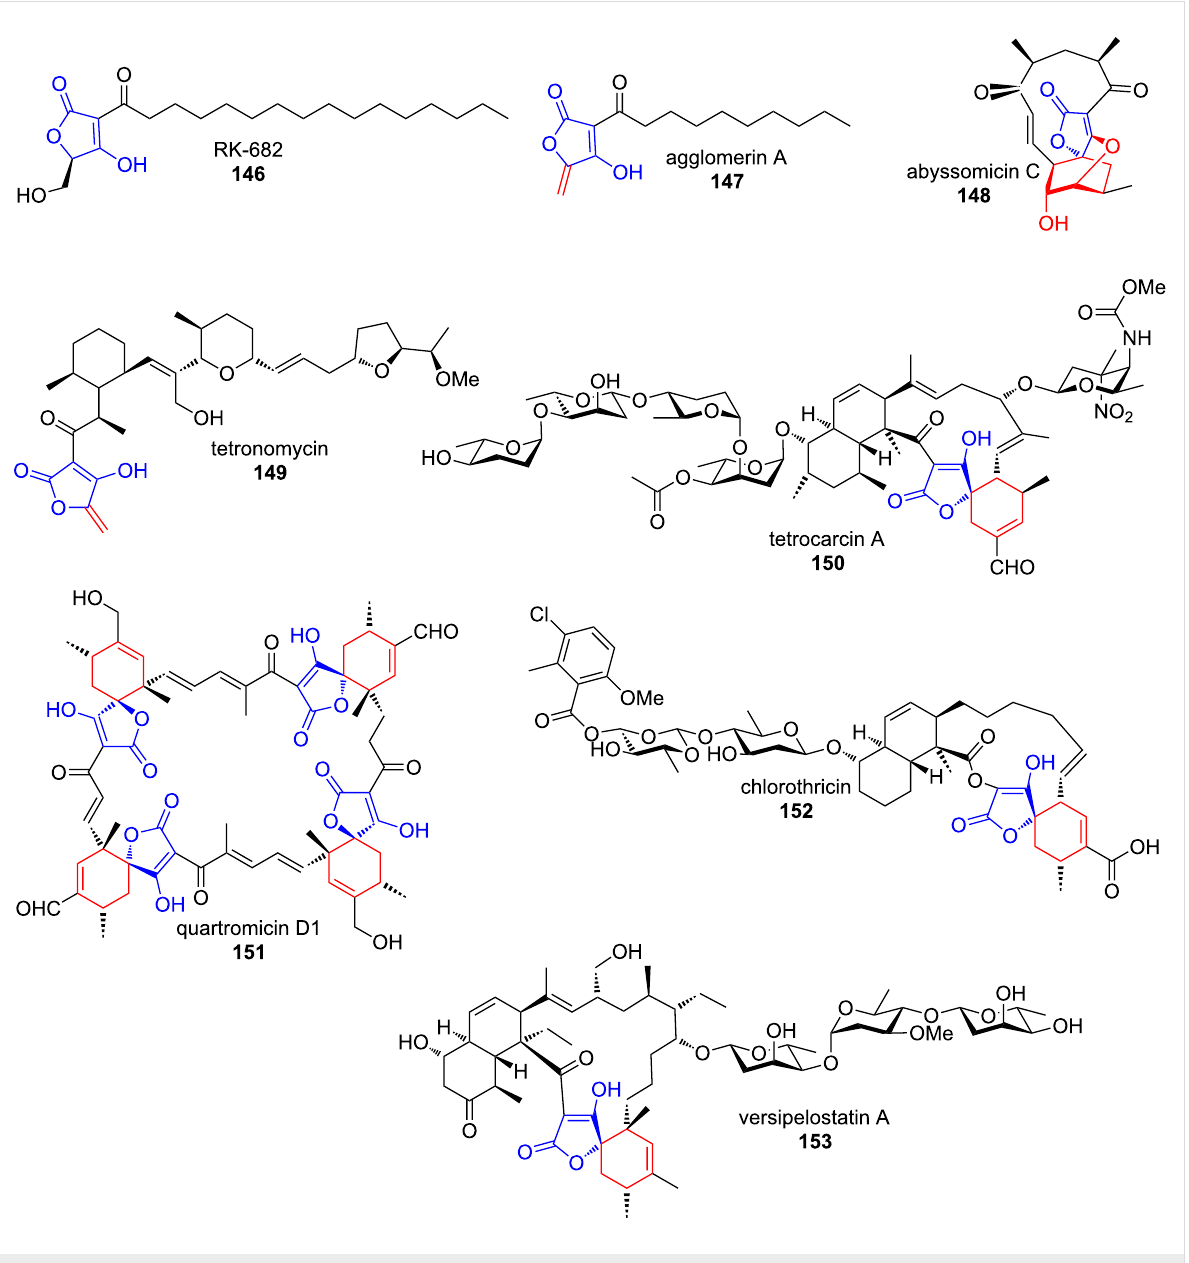
Figure 6: Structures of tetronates for which gene clusters have been sequenced. The tetronate moiety is shown in blue. All structural elements that derive from tailoring processes on the tetronate are shown in red. Kijanimicin is not shown [138,139].